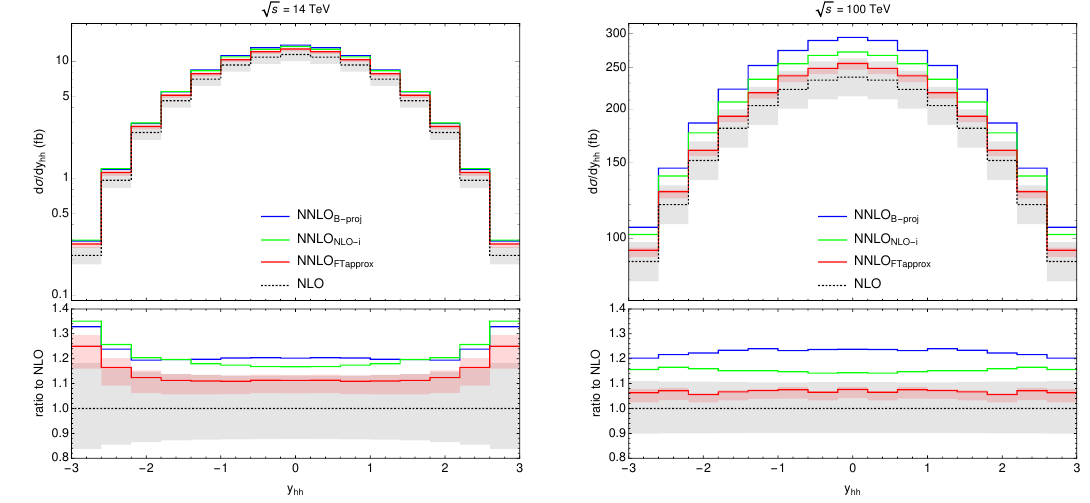
Figure 3 . Higgs boson pair rapidity distribution at NNLO for the di(cid:11)erent approximations, to- gether with the NLO prediction, at 14 TeV (left) and 100 TeV (right). p at s = 100 TeV, the average transverse momentum of the Higgs boson pair in the (cid:12)rst M bin is p (cid:24) 100 GeV at NLO). In this region the exact loop amplitudes hh T ;hh